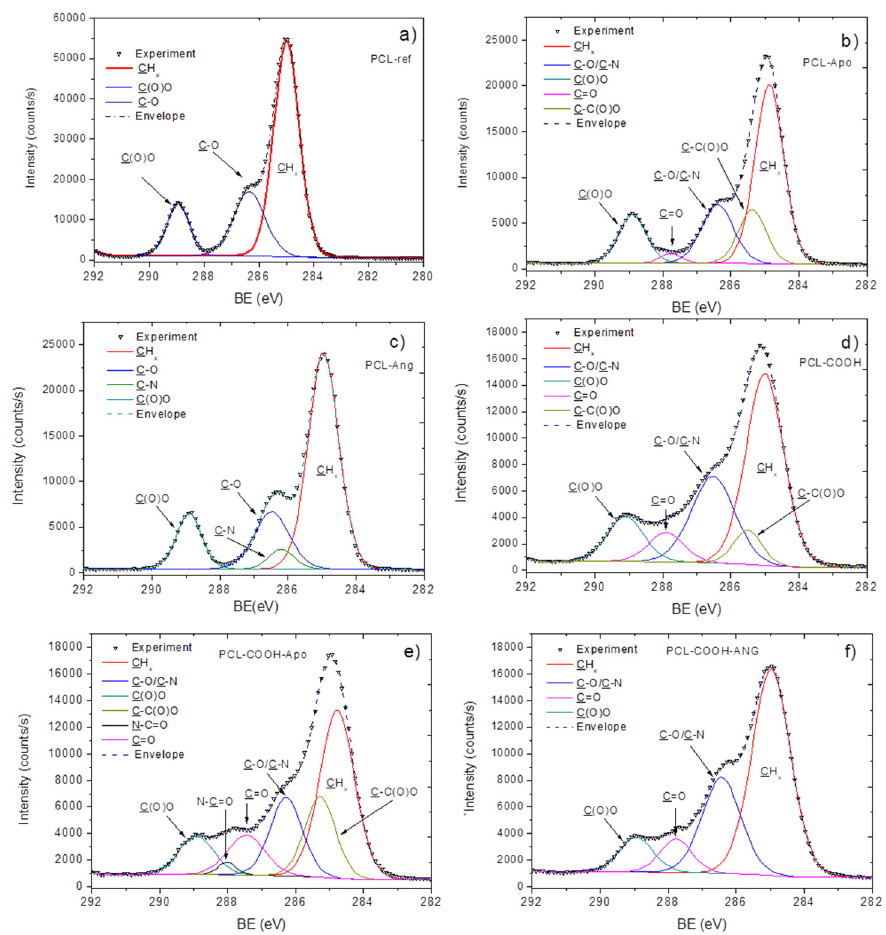
Figure 2. The XPS C1s curve fitting of PCL-ref ( a ), PCL-Apo ( b ), PCL-ANG ( c ), PCL-COOH ( d ), PCL-COOH-Apo ( e ), PCL-COOH-ANG ( f ).